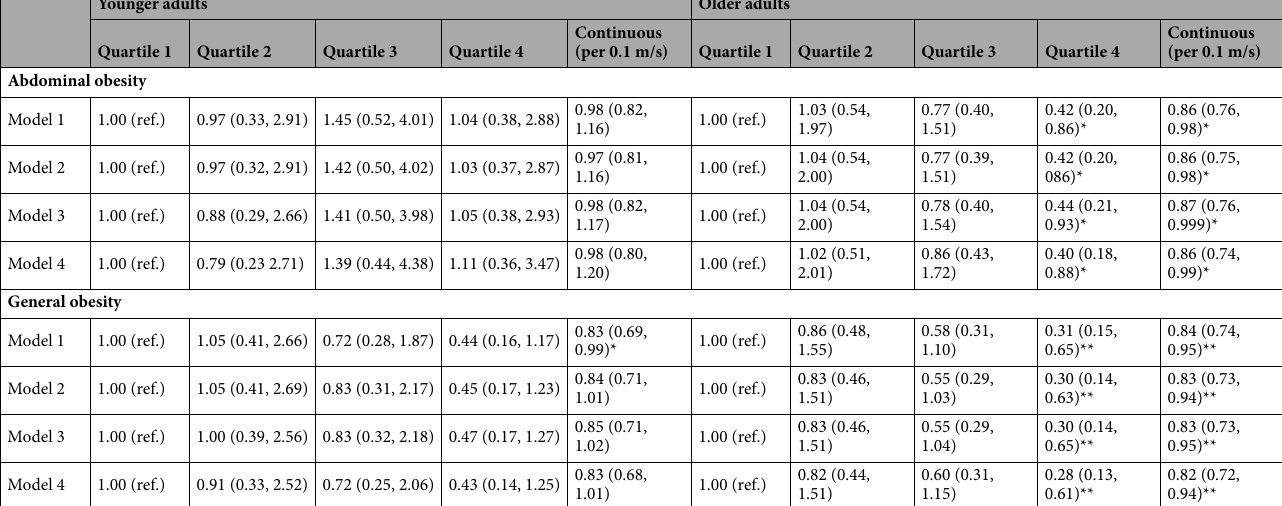
Table 3. Adjusted odds ratio for daily gait speed quartile with abdominal obesity or general obesity. Values are adjusted odds ratios (95% CI). Multiple logistic regression was performed. Model 1 was adjusted for age and sex. Model 2 was adjusted for model 1 plus smoking habits, energy intake, and alcohol intake. Model 3 was adjusted for model 2 plus average steps/day. Model 4 was adjusted for model 3 plus hypertension, diabetes, and dyslipidaemia. * P < 0.05, ** P <